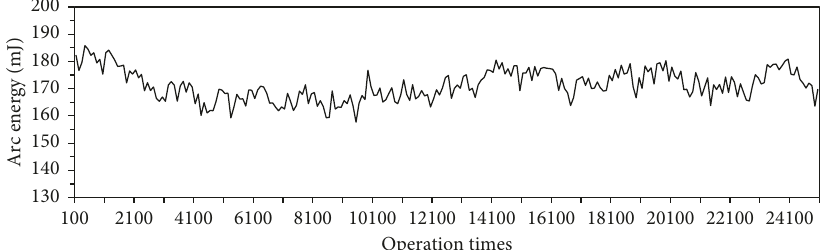
Figure 7: The arc energy of Ag-SnO 2 /Fe 2 O 3 contact material with 50nm doped particle size.